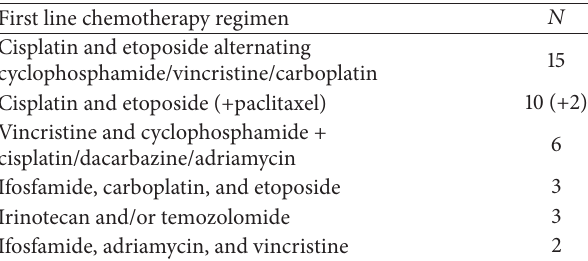
Table 3: First chemotherapy regimens employed in adult neurob-